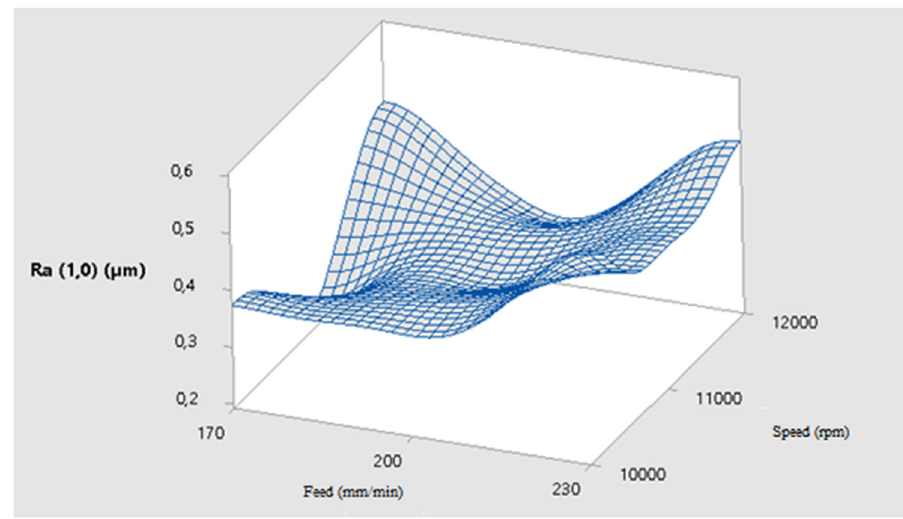
Figure 7: E ff ects of feed rate and rev on surface roughness.